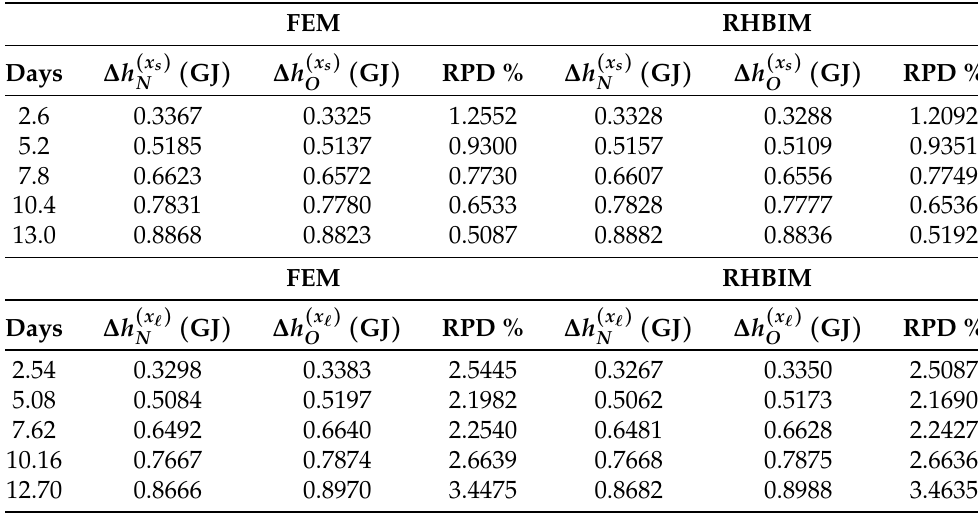
Table 5. RPD between both models during a charging process of KNO 3 /NaNO 3 salt and according to the numerical and semi-analytical solutions to the absorbed energy ∆ h = h ( t ) − h ( 0 ) . FEM